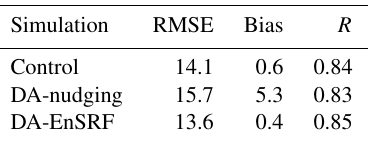
Table 2. Statistical analysis of simulated current velocity at the Lido inlet. Results are given as RMSE (root mean square error, cms − 1 ), bias (difference between the mean of simulation results and obser- vations, cms − 1 ), and R (correlation coefficient between model re- sults and